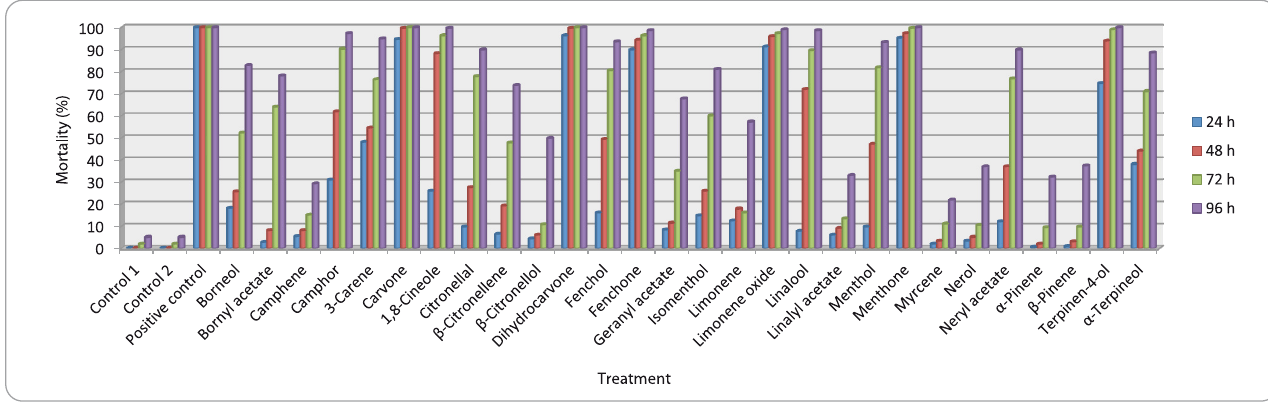
Fig. 2: Total mortality of adults of Sitophilus zeamais according to treatment times of twenty eight monoterpenes